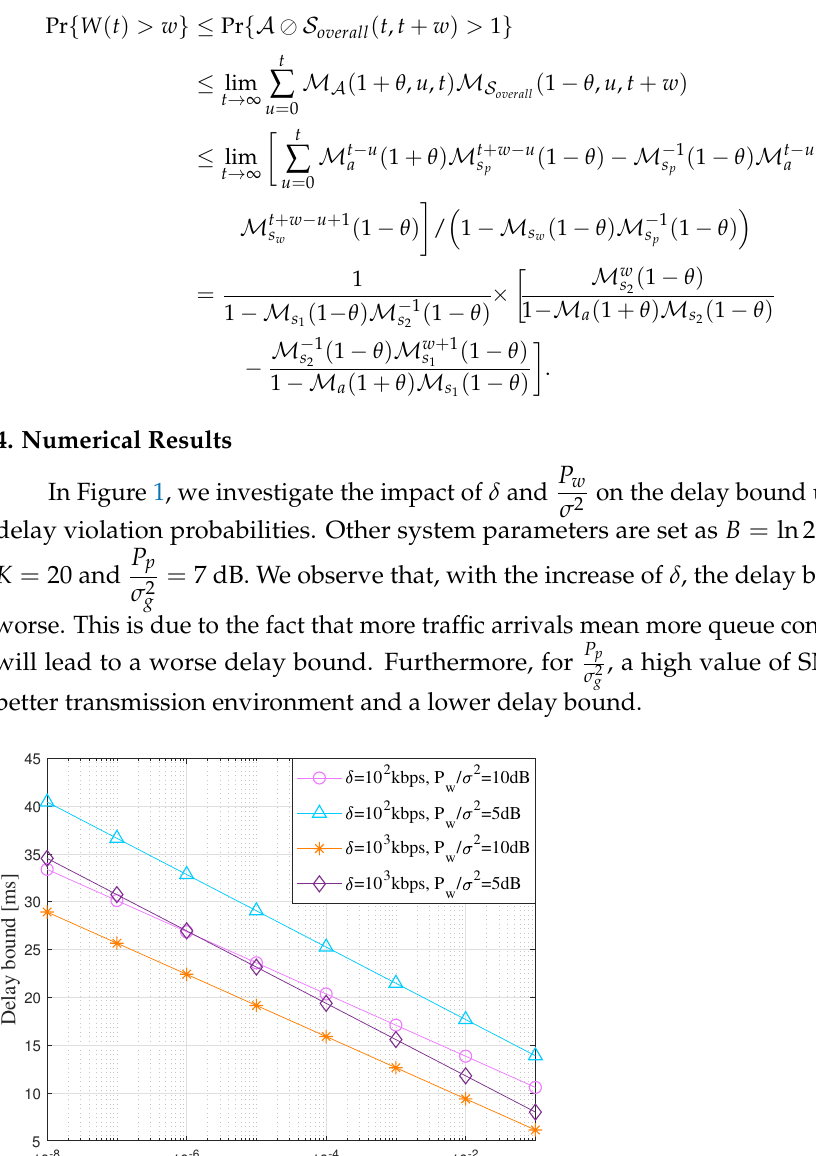
Figure 1. Delay versus violation probability under various data flows and